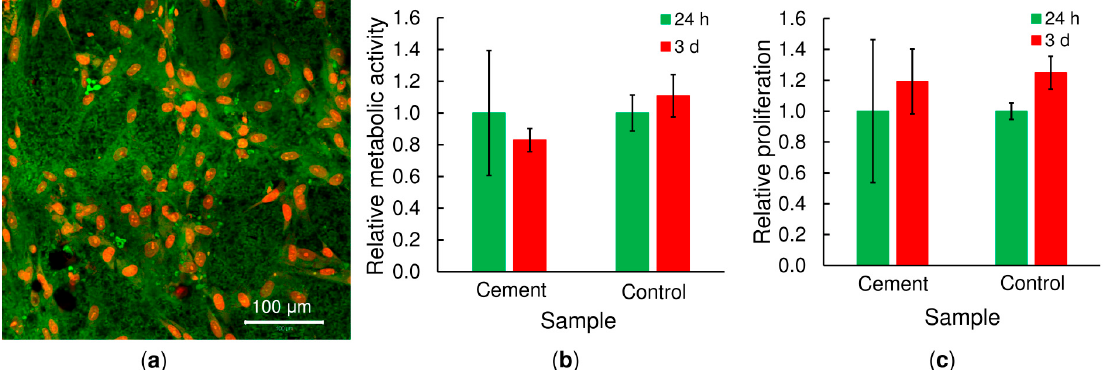
Figure 9. Cytocompatibility test on hMSCs; the cell morphology after 3 days of seeding on copolymer/ α -TCP disks (20 w / v % copolymer, L/P of 0.5 g · g − 1 ; setting for 10 days), cells seeded on scaffolds were visualized using confocal microscopy (DiOC6(3) – green color; propidium iodide – red color), scale bar = 100 µ m ( a ). Cell metabolic activity was determined using MTS test ( b ); cell proliferation was determined in terms of the quantification of the amount of DNA at 24 hours and 3 days ( c ). Cells seeded on tissue culture plastic were used as a control and the data in b and c were normalized to the values obtained after 24 h of cell culture.